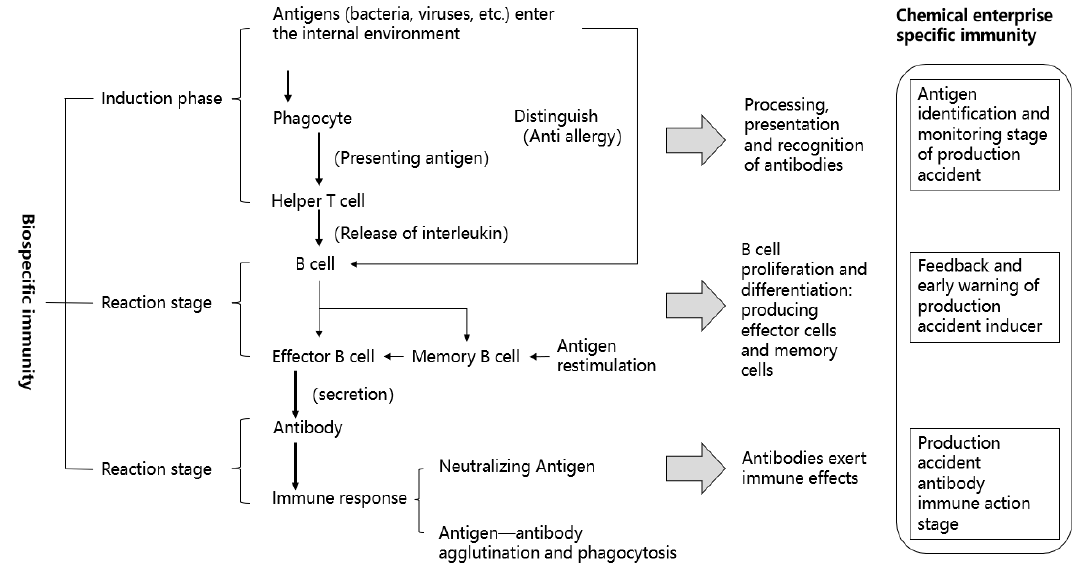
Figure 2. Similarity of enterprise-specific immunity and immune